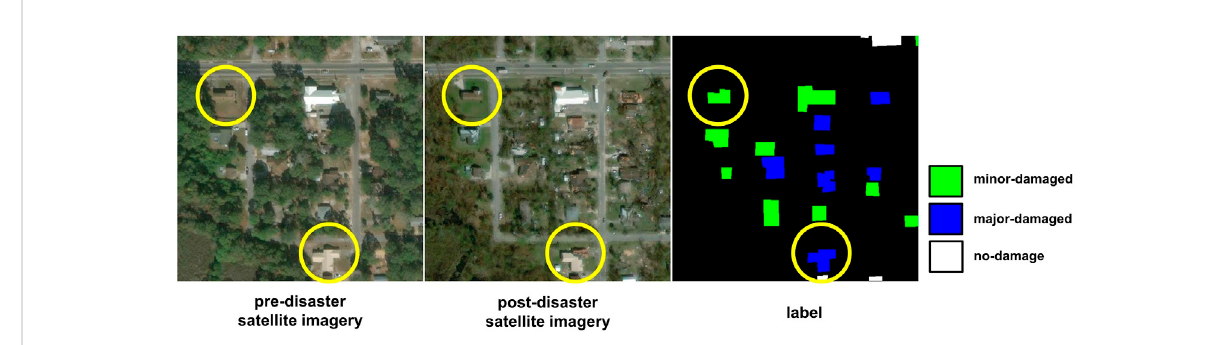
FIGURE 4 Examples of damage labels extracted from the xDB database. The pre- and post-disaster images of minor damaged structures are nearly identical, yet they show substantial visual differences for major damaged